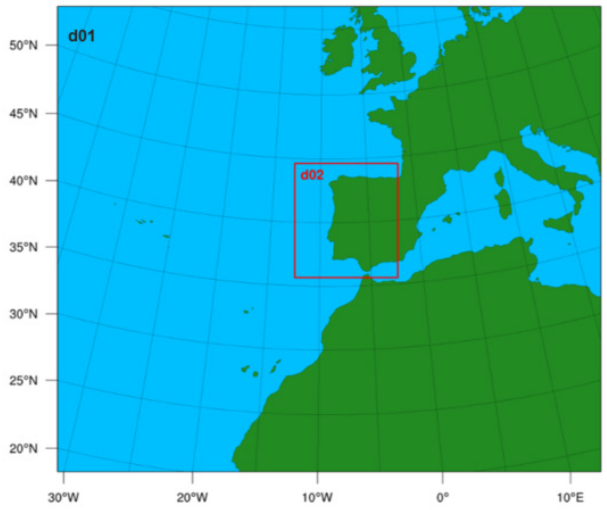
Figure 1. Weather Research and Forecasting (WRF)-Chem simulation domains.